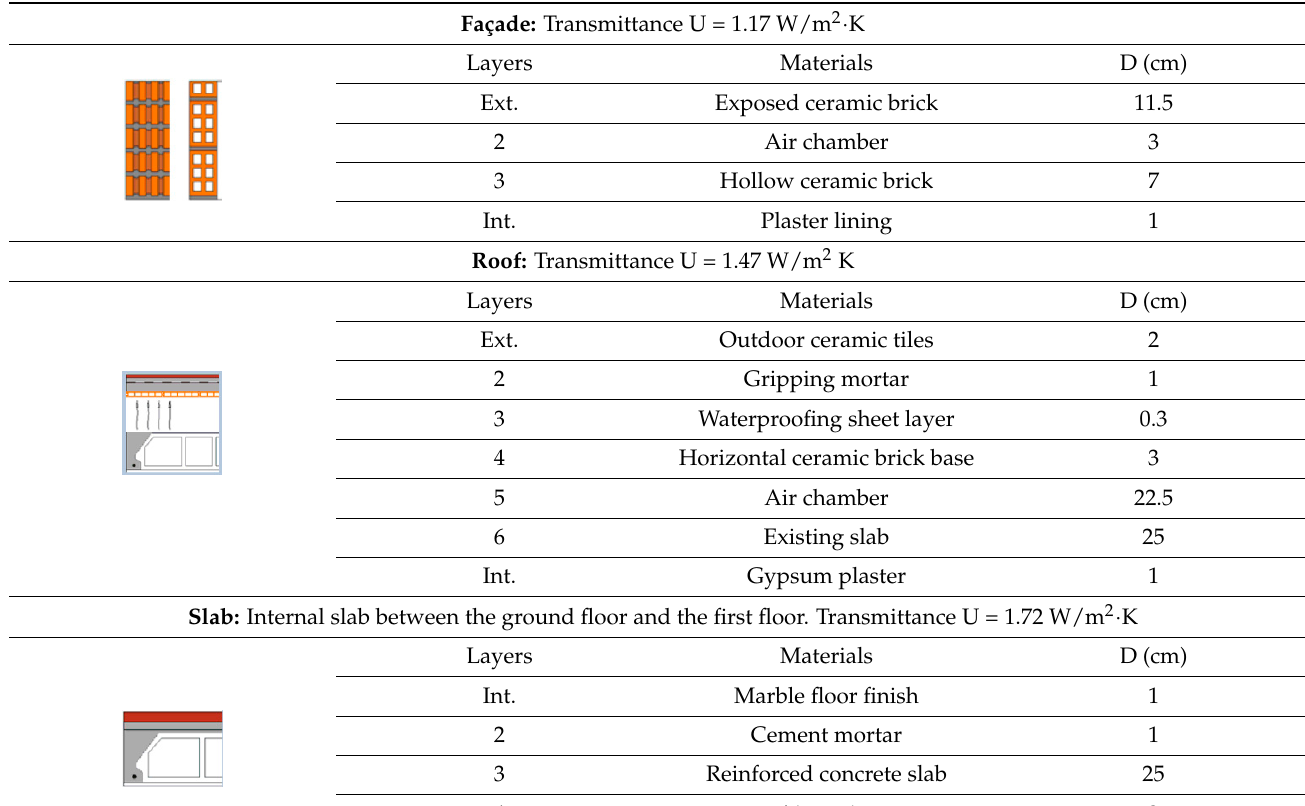
Table A1. Main thermal and geometrical properties of the present building envelope and systems.